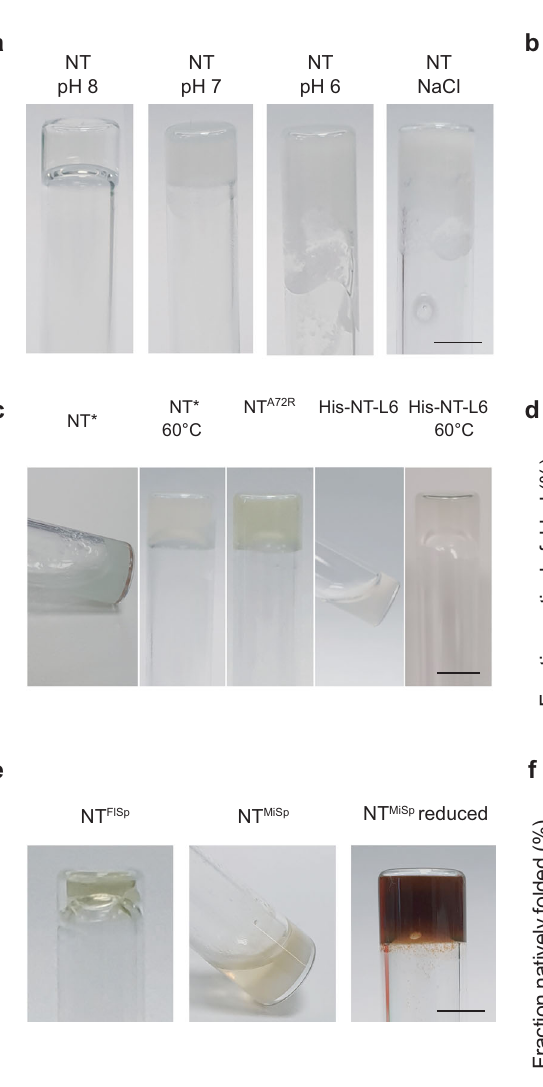
secondary structure are indicated. e Fibrillation propensity pro fi le of NT 45,79 according to the Zipper database (https://services.mbi.ucla.edu/zipperdb/). Rosetta energies in kcal/mol of moving windows of hexapeptide steric zippers are shown. Red bars indicate hexapeptides with high fi brillation propensities (Rosetta energies below − 23kcal/mol; below dotted line). Green bars indicate Rosetta energies above the threshold which hence are segments that are unlikely to form stericzippers.Segmentscontainingprolineareomittedfromtheanalysis(nobars). The square indicates a predicted amyloidogenic region according to the Waltz algorithm 81 , (https://waltz.switchlab.org). Amino acid residue sequence of NT on topwithresiduetypesfoundin β secondarystructure(asdeterminedbysolid-state NMR spectroscopy) indicated in red. The positions of the fi ve α -helices of NT are indicated (H1-H5) 28 .